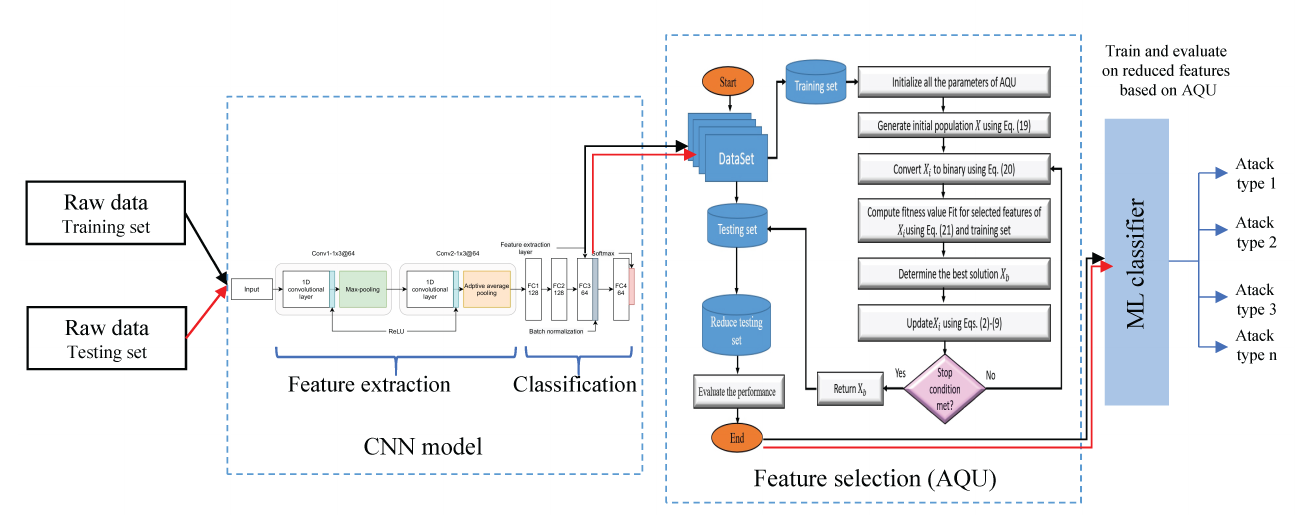
Figure 1. Structure of presented IoT security